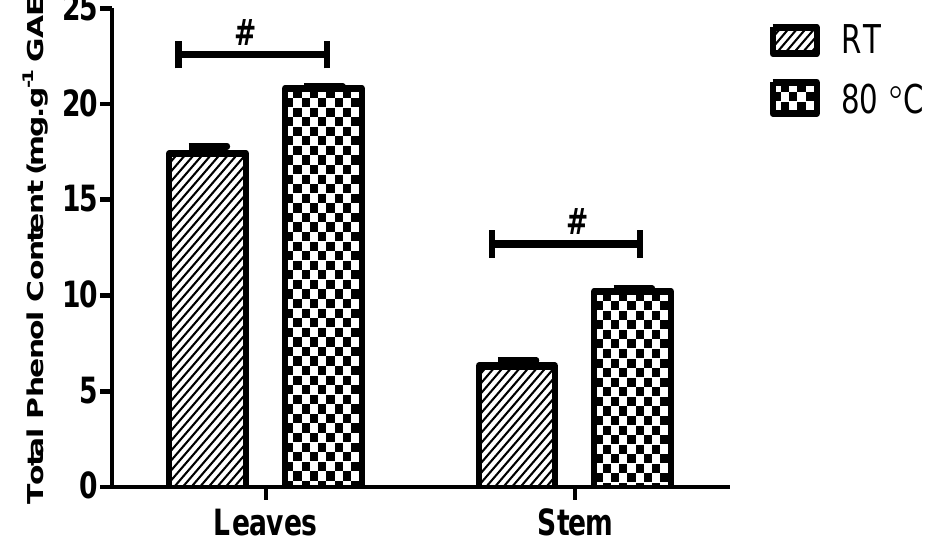
Figure 9. Comparison of total phenol content (mg/g) of D. villosa leaves and stem AgNPs at room temperature and at 80 °C. F (1,8) = 219, p < 0.0001. # (RT vs. 80 °C), p < 0.001.